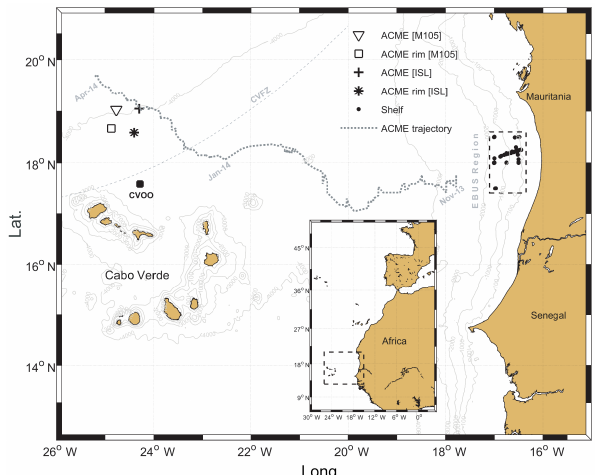
Figure 1. Map of the study area between the Mauritanian coast and the Cabo Verde archipelago. The ACME trajectory (dotted line) is based on satellite sea level anomaly data and starts off the Maurita- nian shelf edge in September 2013. In March 2014, the ACME was surveyed twice north of Cabo Verde with two different research ves- sels: RV Islândia (ISL) and RV Meteor (M105). The area marked on the Mauritanian shelf (dashed line) represents the area where the ACME was most likely created and which serves as a reference for initial conditions within the